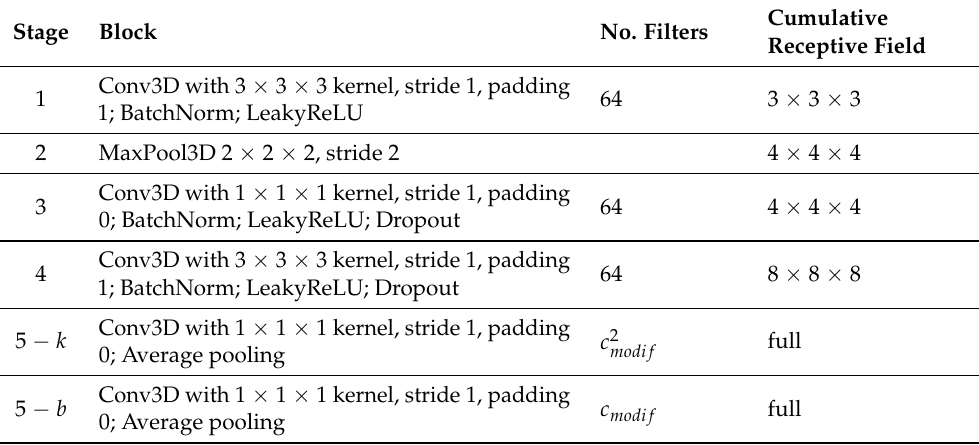
Table 3. CNN architecture for computation of k and b employed inside the coupling